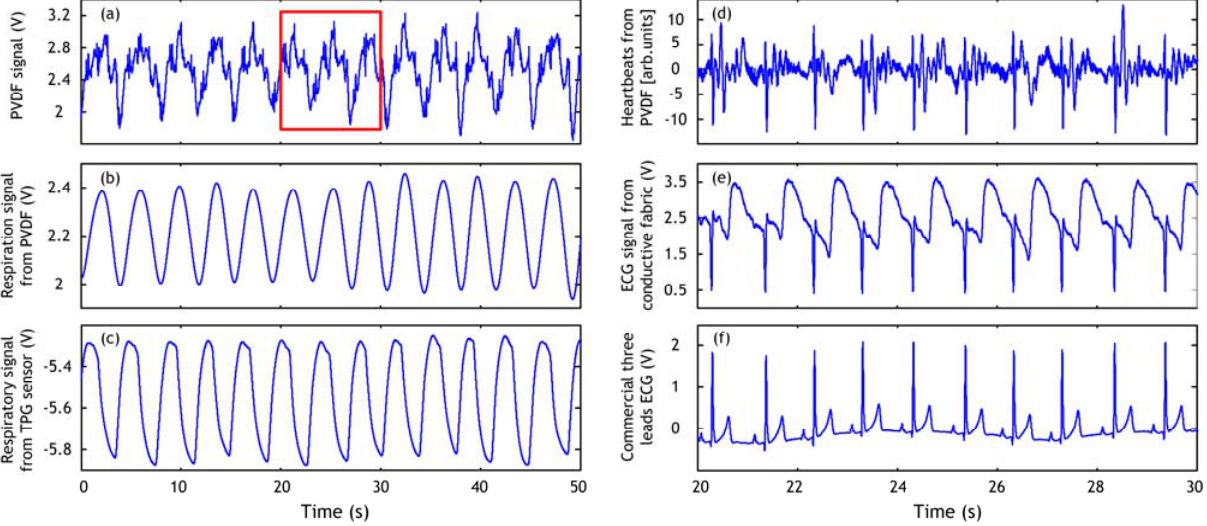
Figure 5. (a) Signal acquired using PVDF sensor. (b) Respiration signal derived from (a) by applying LPF (0.33 Hz cutoff frequency, − 61 db Blackman window). (c) Respiration signal obtained with TPG sensor. (d) Heartbeats derived form (a), in the rectangle range; by applying derivative function and HPF (1 Hz cutoff frequency, − 61 db Blackman window). (e) ECG signal obtained with conductive fabric sensor in the same range of (d). (f) ECG signal obtained with commercial three leads ECG in the same range of (d,